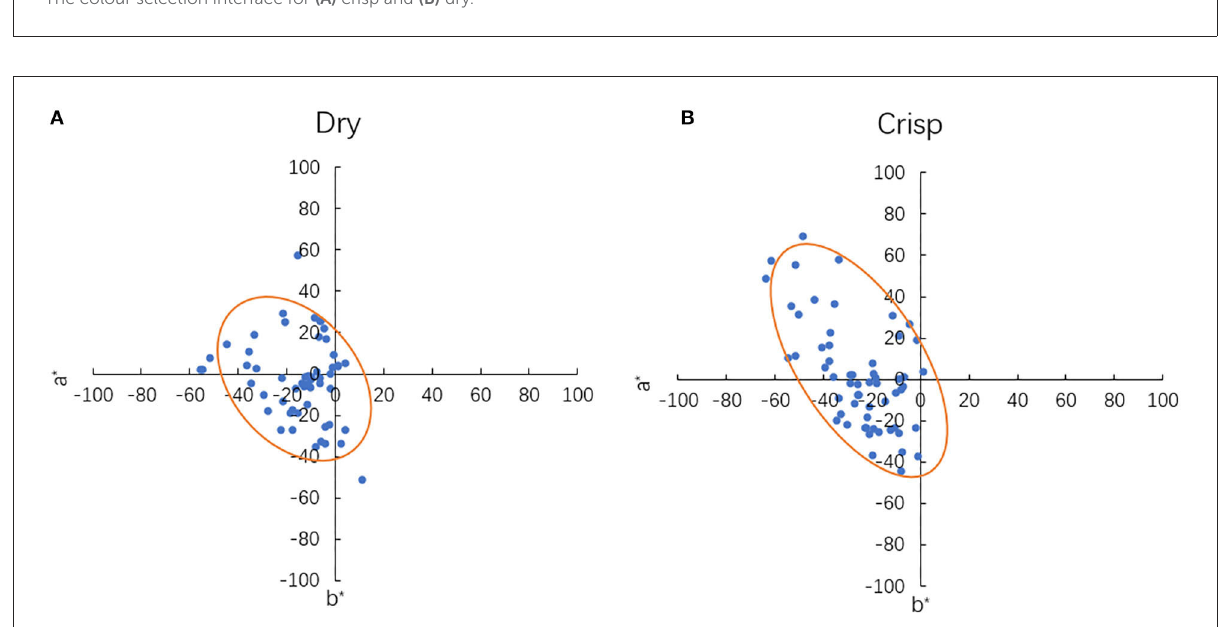
FIGURE2 The colour distribution of selected colour in CIE a * b * plane: (A) crisp; (B)